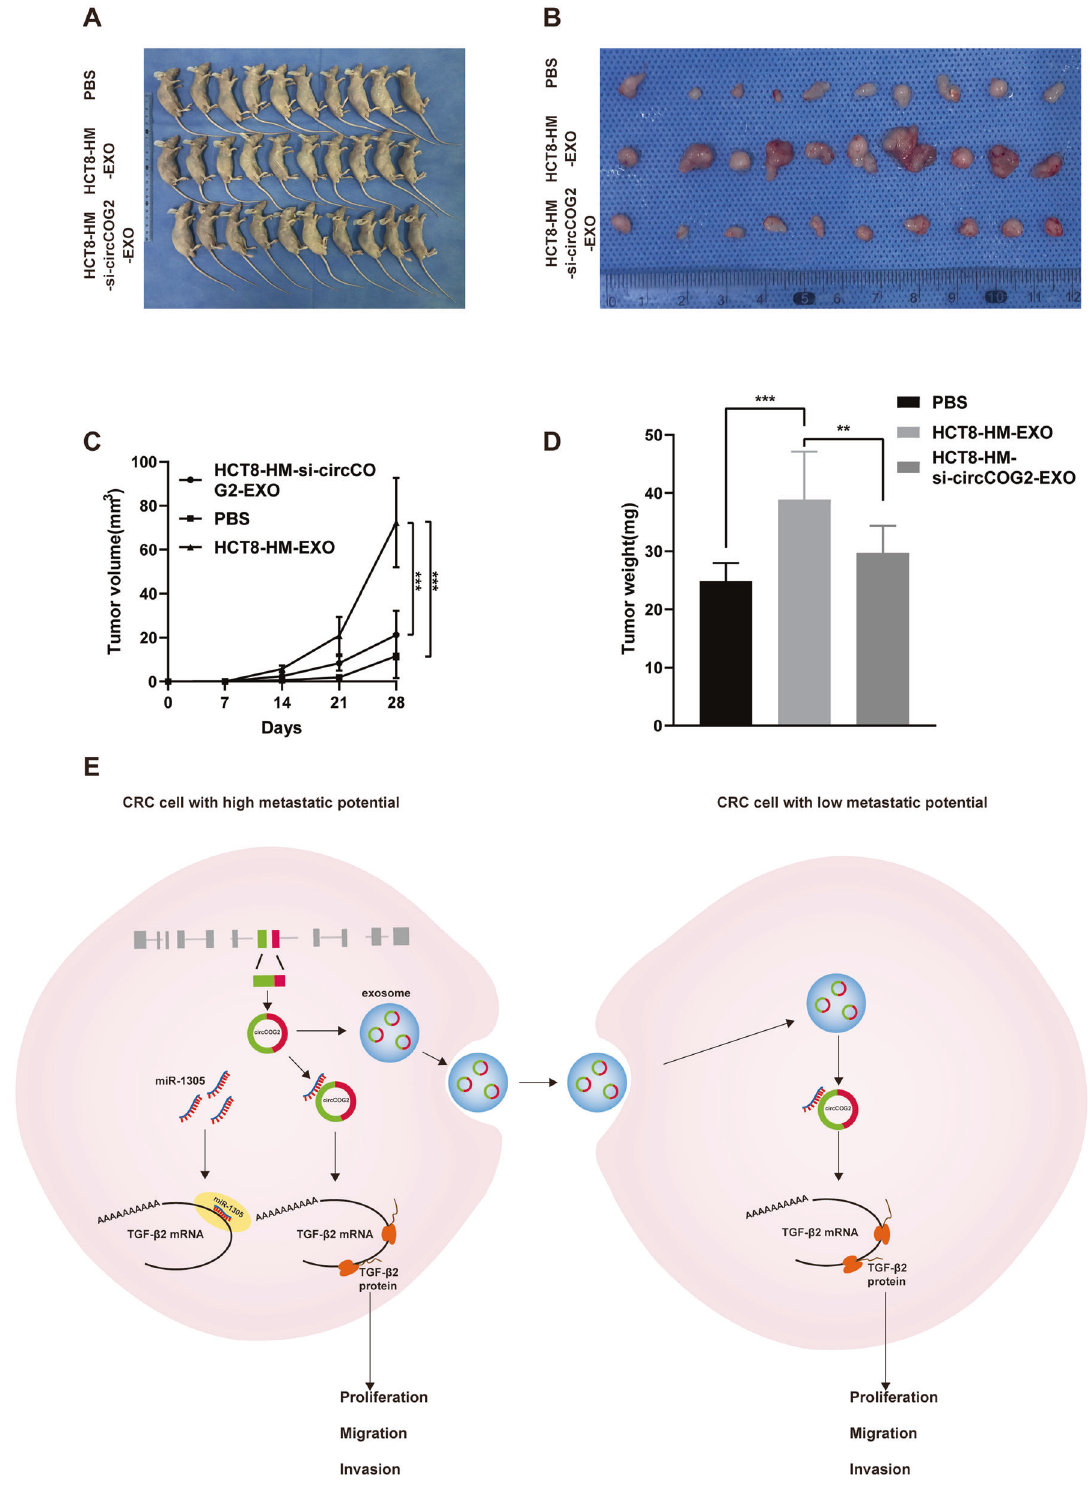
Fig. 7 Exo-transmitted circCOG2 promotes CRC progression in vivo. A The xenograft tumors assay showed the tumors after four weeks of growth. B The represented image of the removal tumor. C The volume of the tumor measured once a week in each group. D The fi nal weight of tumor in each group. E The molecular mechanism of circCOG2 in CRC. * P < 0.05; ** P < 0.01; P values were calculated by Student ’ s t -test. nuclear-induced chemoresistance of breast cancer by inhibiting These results indicated that circCOG2 had an important role in the transcription of SMARCA5 [19]. Moreover, circLONP2 promotes CRC progression, which urged us to study the mechanism further. CRC migration and invasion by regulating the maturation of pri- A few circRNAs are retained in the nucleus where they regulate miR-17 [20]. Yet, most circRNAs are located in the cytoplasm and transcription and splicing. E.g., downregulates circSMARCA5 in